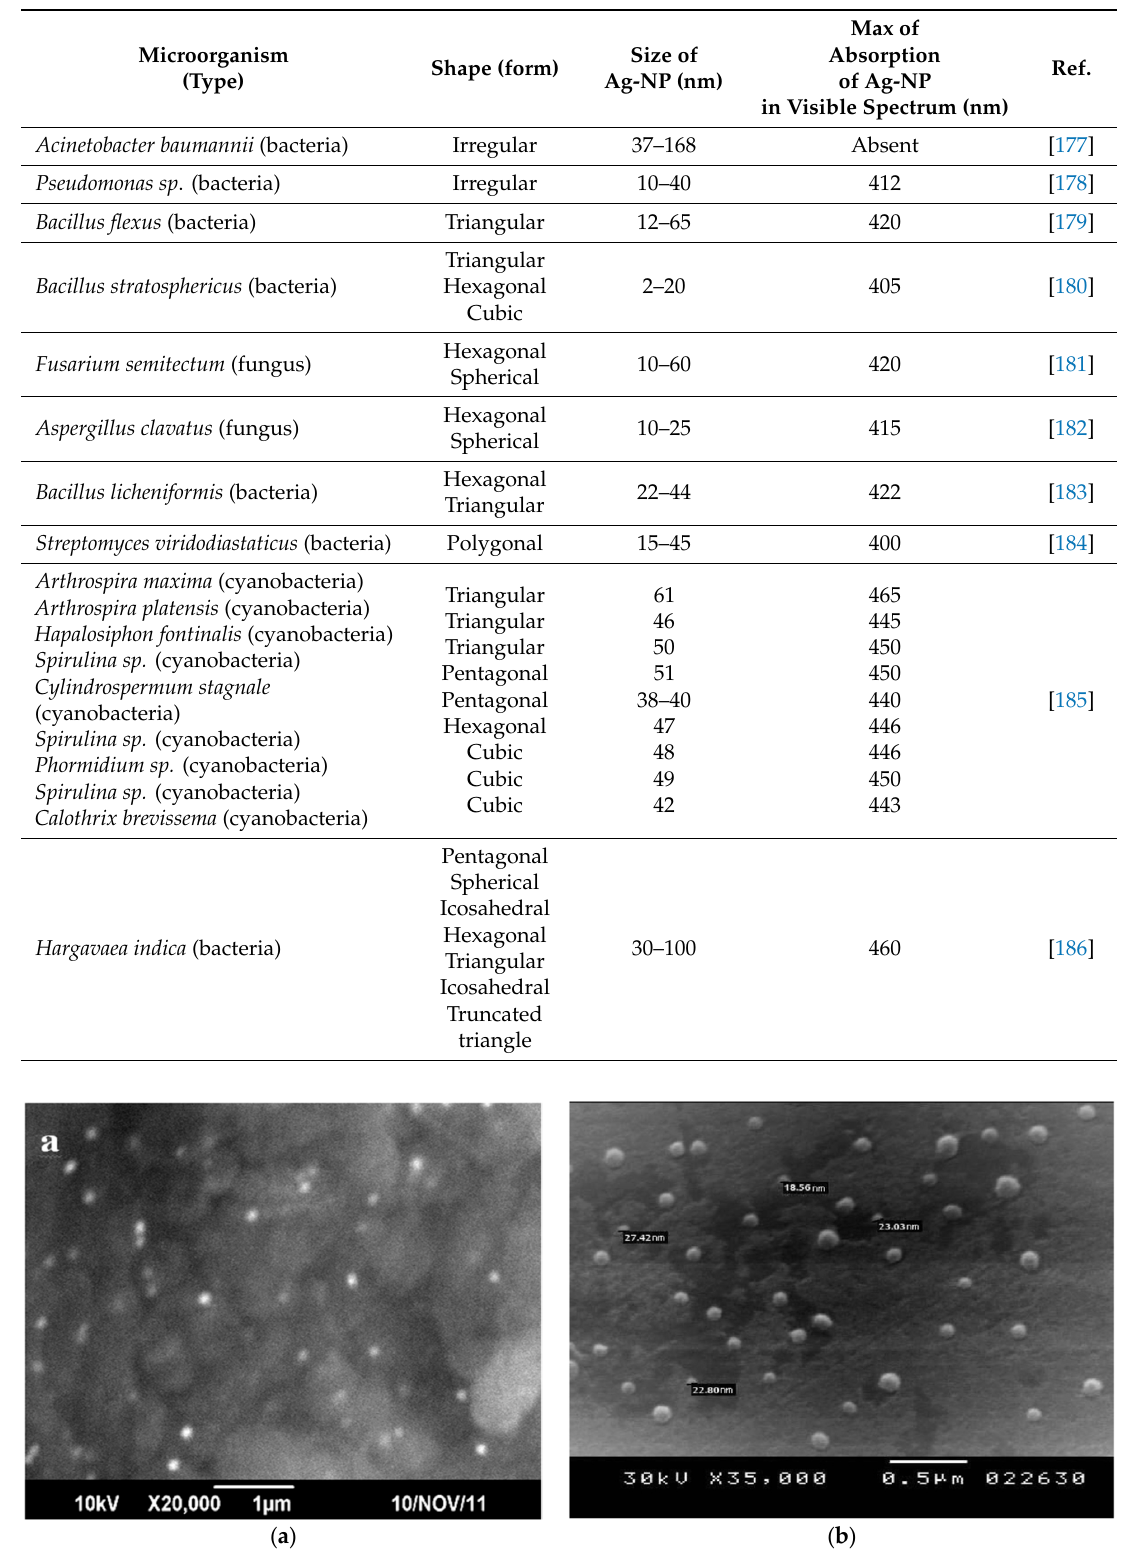
Figure 7. SEM of spherical Ag-NP obtained in [147] ( a ) and obtained in [155] ( b ).